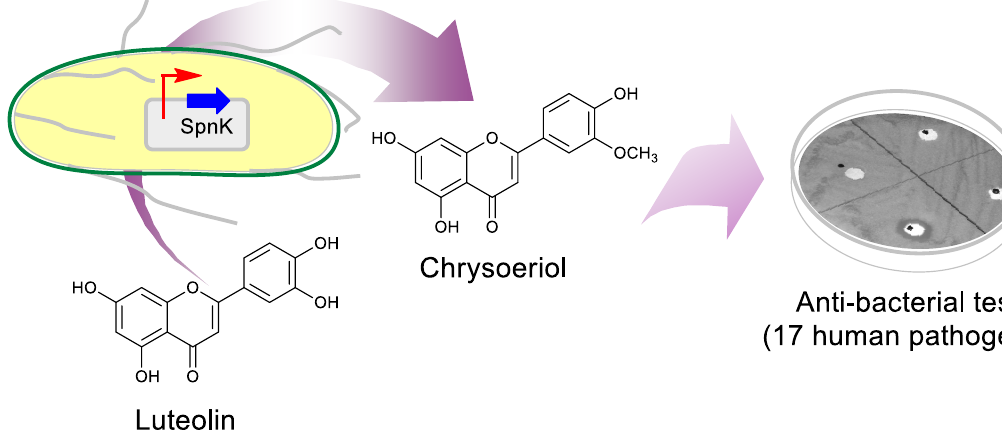
Figure 1. Schematic representation of the biosynthesis of chrysoeriol from Escherichia coli and its antibacterial test against human pathogens.